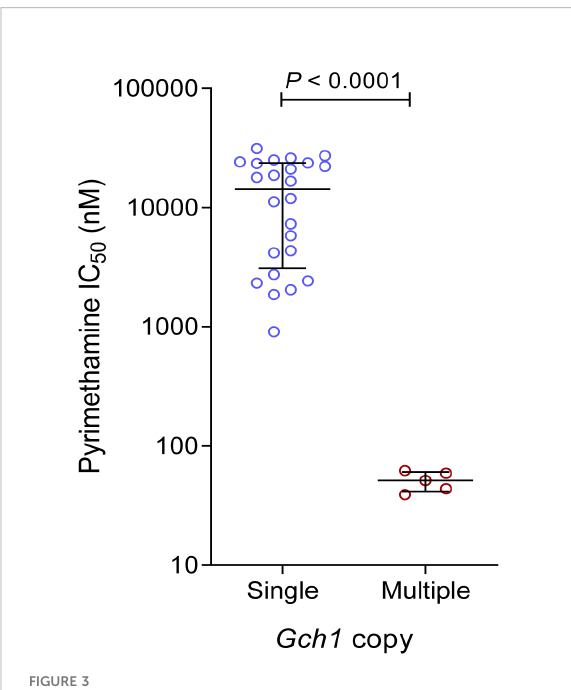
FIGURE 3 Comparison of in vitro susceptibilities (IC 50 values) to pyrimethamine between parasites with a single copy and multiple copies of pfgch1